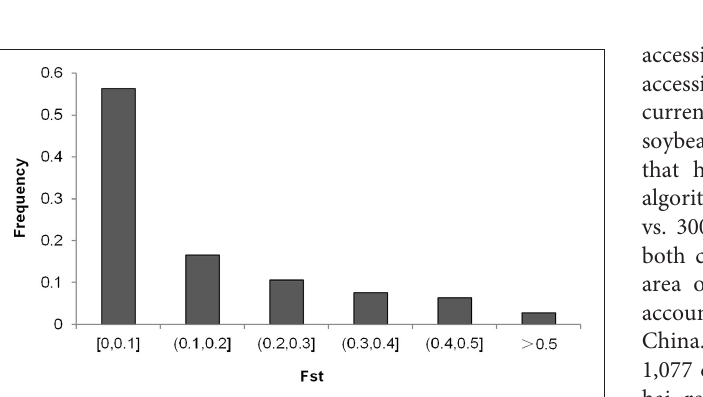
distributed on chromosomes 5, 7, 10, and 12, but no specific allele existed in the US-set ( Table 3